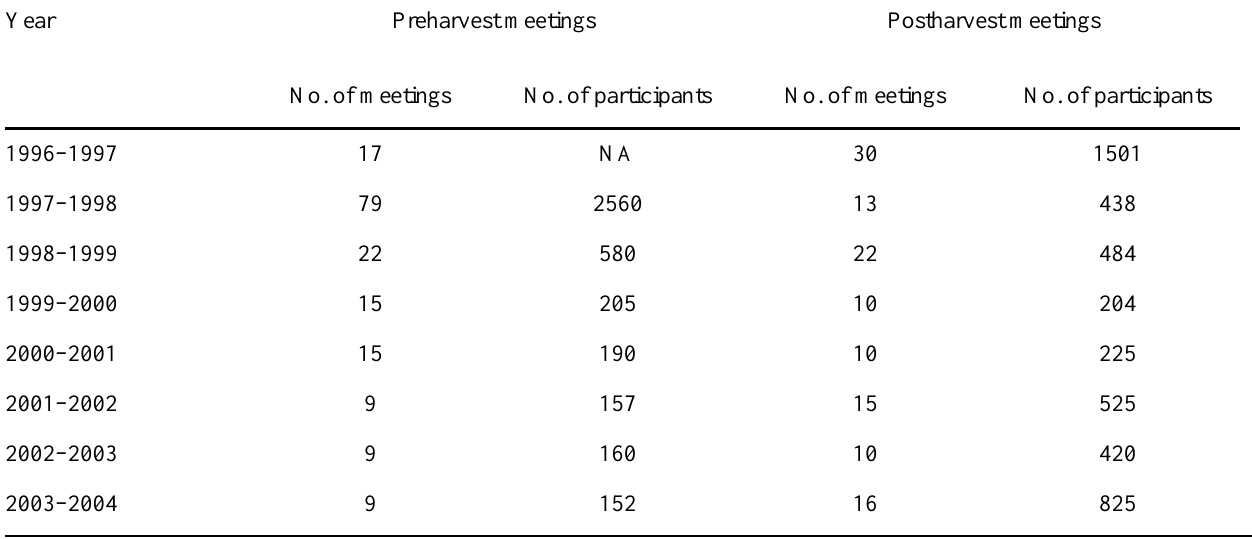
Table 3 . Number of annual pre- and postharvest meetings that took place in the Yelandur range of the Biligiri Rangaswamy Temple Wildlife Sanctuary between 1996 and 2004. Participatory monitoring data were shared at the postharvest